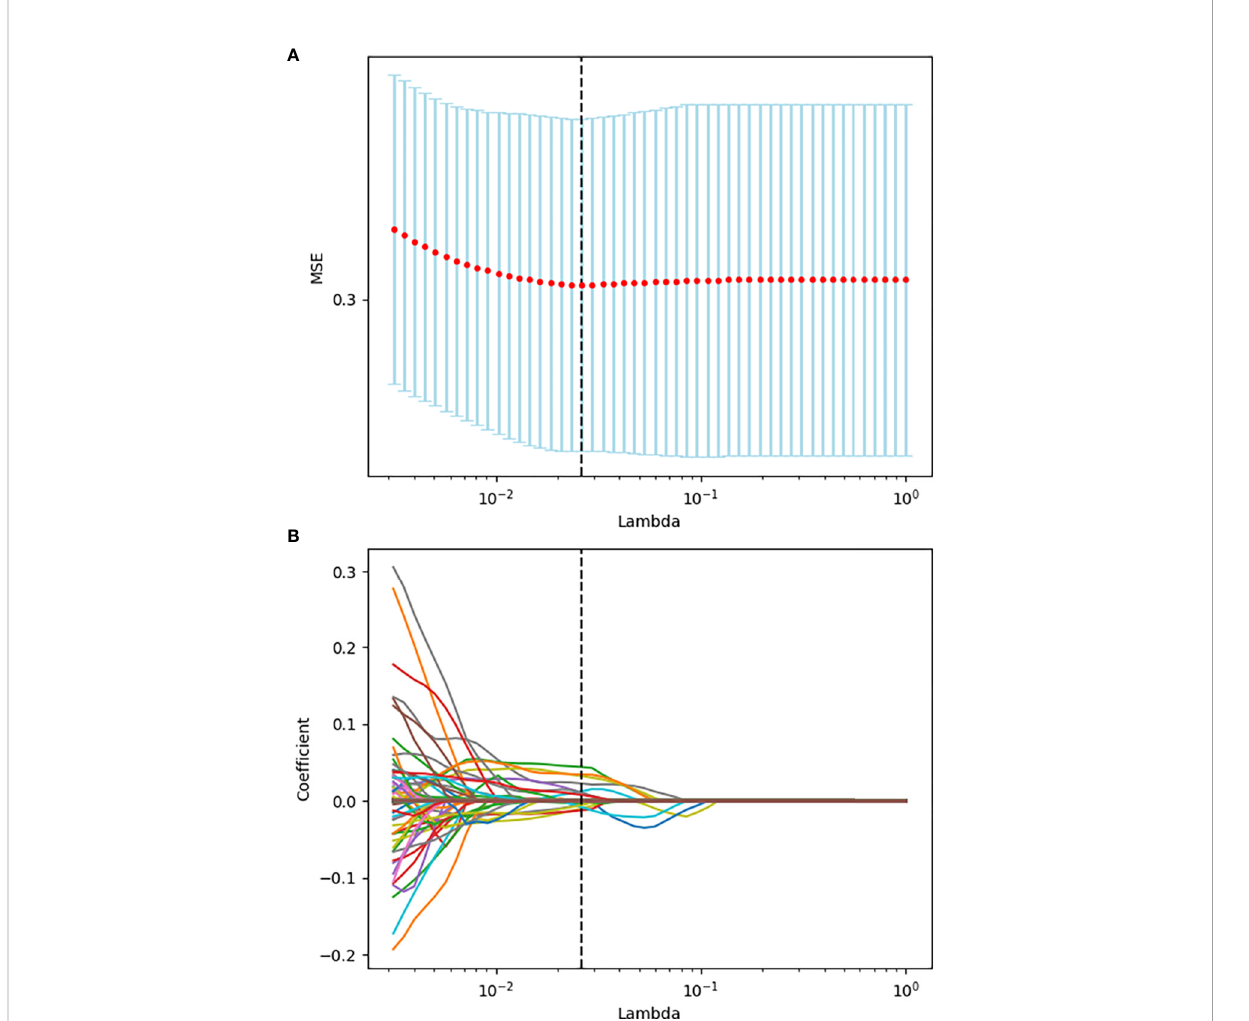
FIGURE 3 Tuning parameter selection using the LASSO regression in the training set. (A) The optimal penalization coef fi cient lambda was generated in the LASSO via tenfold cross-validation. The lambda value of the minimum mean square error for the training set was given for the features with non-zero selection coef fi cient; (B) LASSO coef fi cient pro fi les of the radiomics